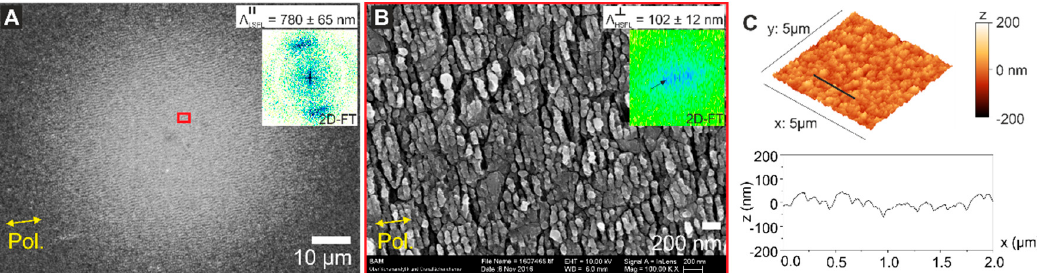
Figure 5. ( A ). Top-view SEM micrograph of a spot made under the same irradiation conditions of the also possible to detect the formation LSFL parallel to the beam polarization with periodicity Λ